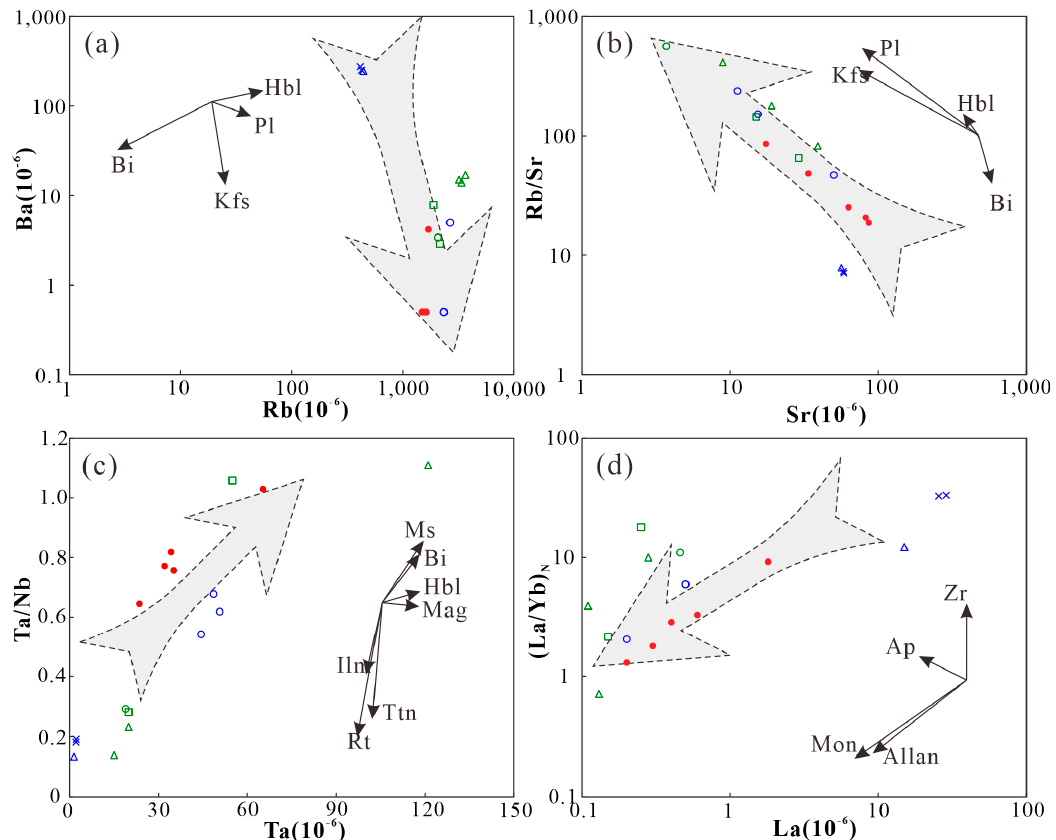
Figure 7. Discrimination diagrams of the fractional crystallization processes of the Dongcao muscovite granite: ( a ). Ba vs. Rb discrimination diagram; ( b ). Rb/Sr vs. Sr discrimination diagram; ( c ). Ta/Nb vs. Ta discrimination diagram; ( d ). (La/Yb) N vs. La discrimination diagram. (Legend description: Pl: plagioclase; Kfs: potassium feldspar; Bi: biotite; M S : muscovite; Hbl: hornblende; Mag: magnetite; Ilm: ilmenite; Rt: rutile; Ttn: sphene; Zr: zircon; Ap: apatite; Mon: monazite; Allan: epidote. The red dots are data of the Dongcao muscovite granite samples in this paper; the blue crosses are data of the Dagang protolothionite muscovite granite; the blue triangles are data of the Dagang pegmatitic dike; and the blue circles are data of the Dagang lepidolite alkali–feldspar granite [8]; the green circles are data of the Baishuidong Li–rich muscovite granite; the green rectangles are data of the Baishuidong trilithionite granite; and the green triangles are data of the Baishuidong aplite [7]).